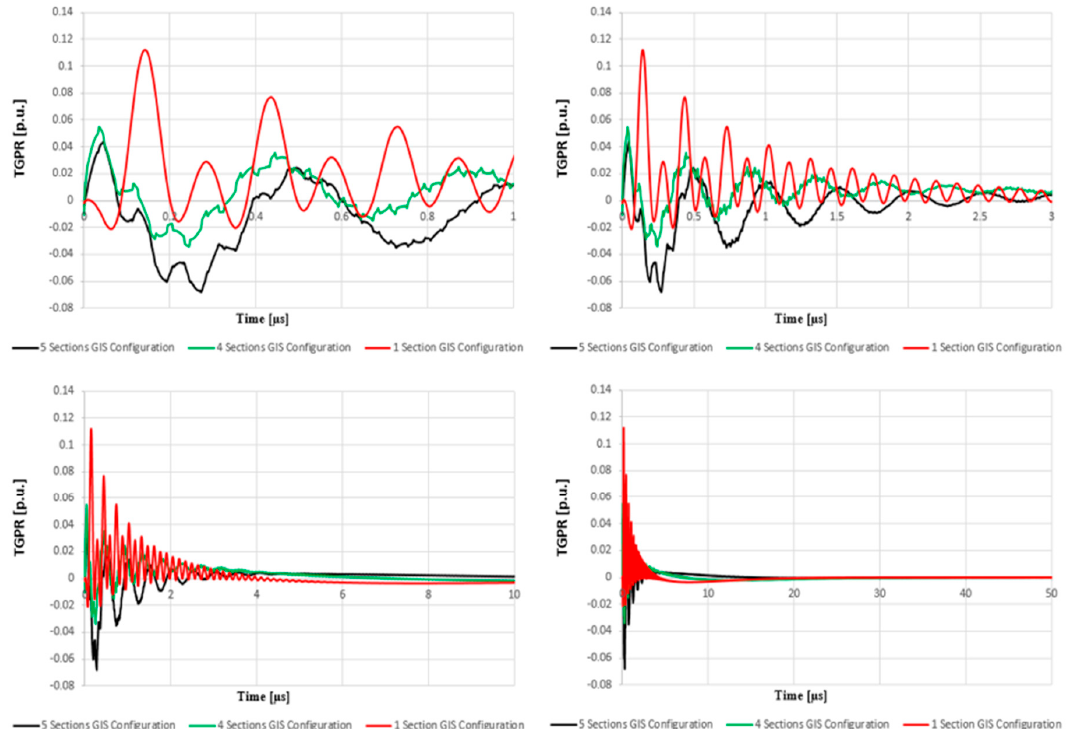
Figure 8. Transient ground potential rise on the grounding lead associated with BUS4.